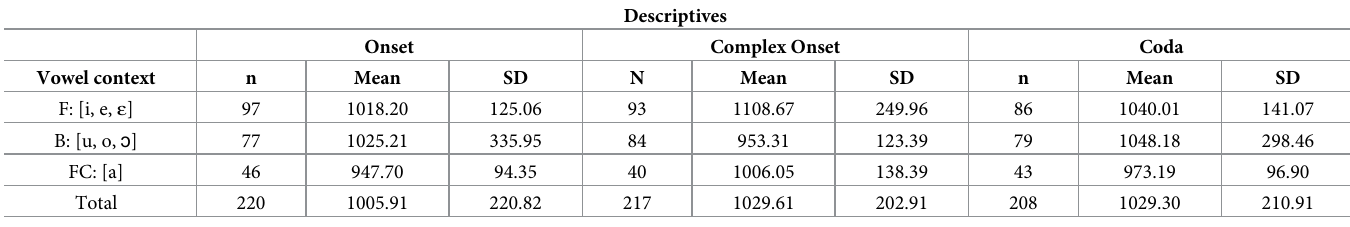
(in Hz) at the midpoint of the steady 2